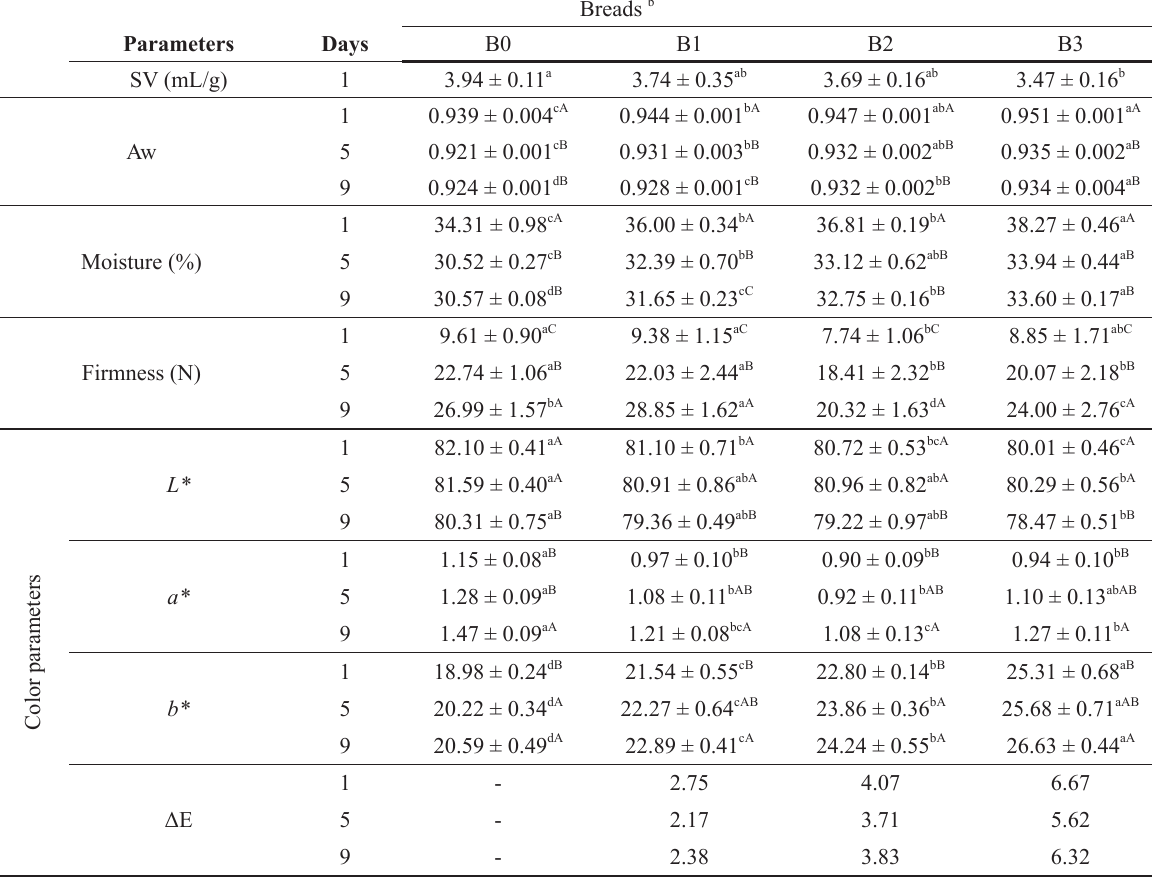
Technological parameters of breads with replacement of WF by SPF during storage a . Breads